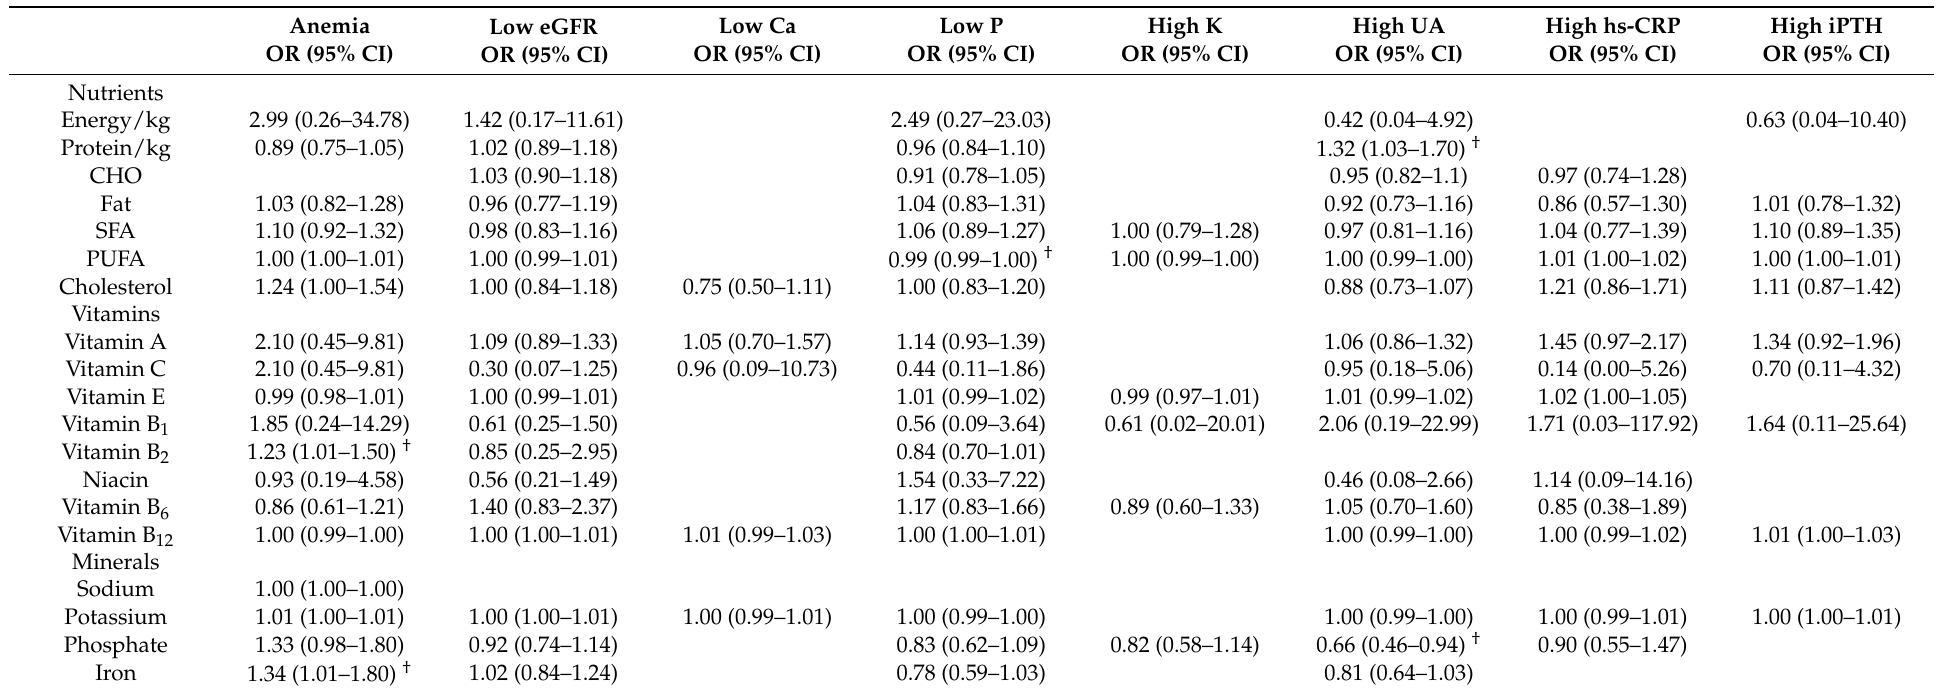
Table 4. Odds ratios of having non-traditional cardiovascular disease risk factors among renal transplant recipients with adequate nutrient